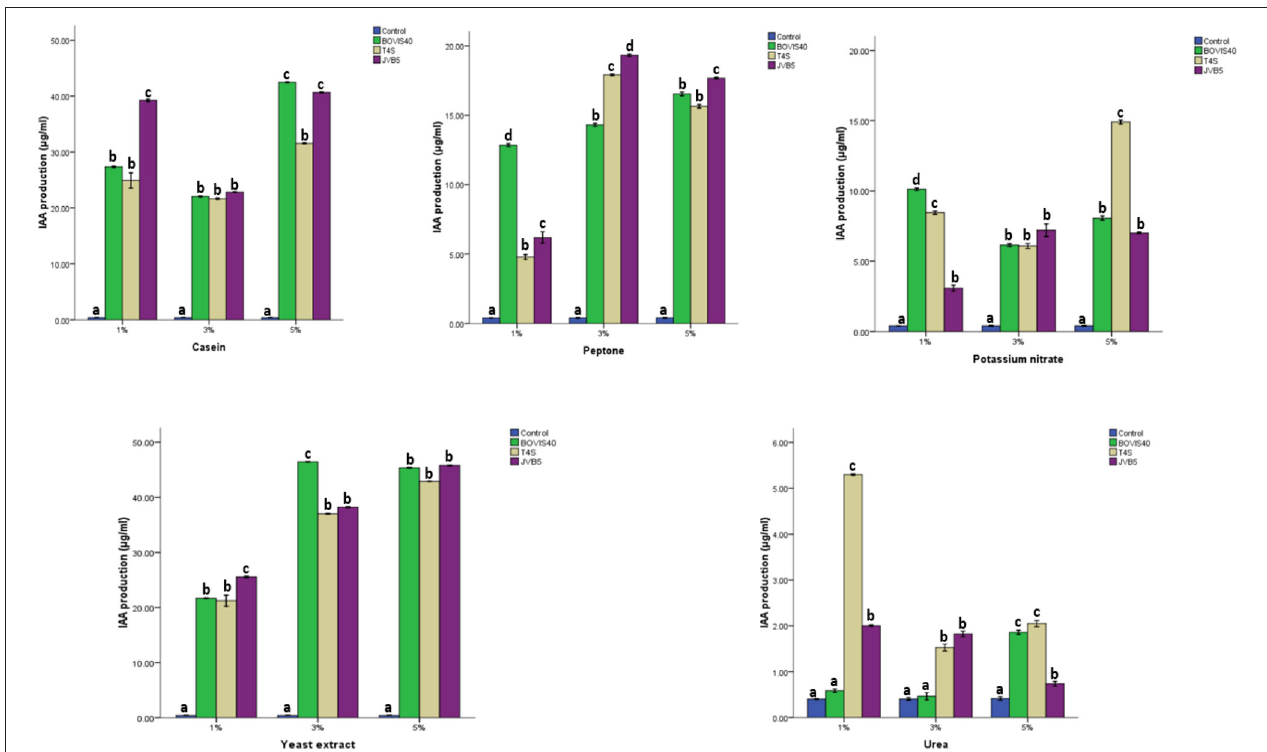
FIGURE 9 | Effect of different nitrogen sources on IAA production by endophytic bacteria. The different alphabets indicate significant differences in triplicate